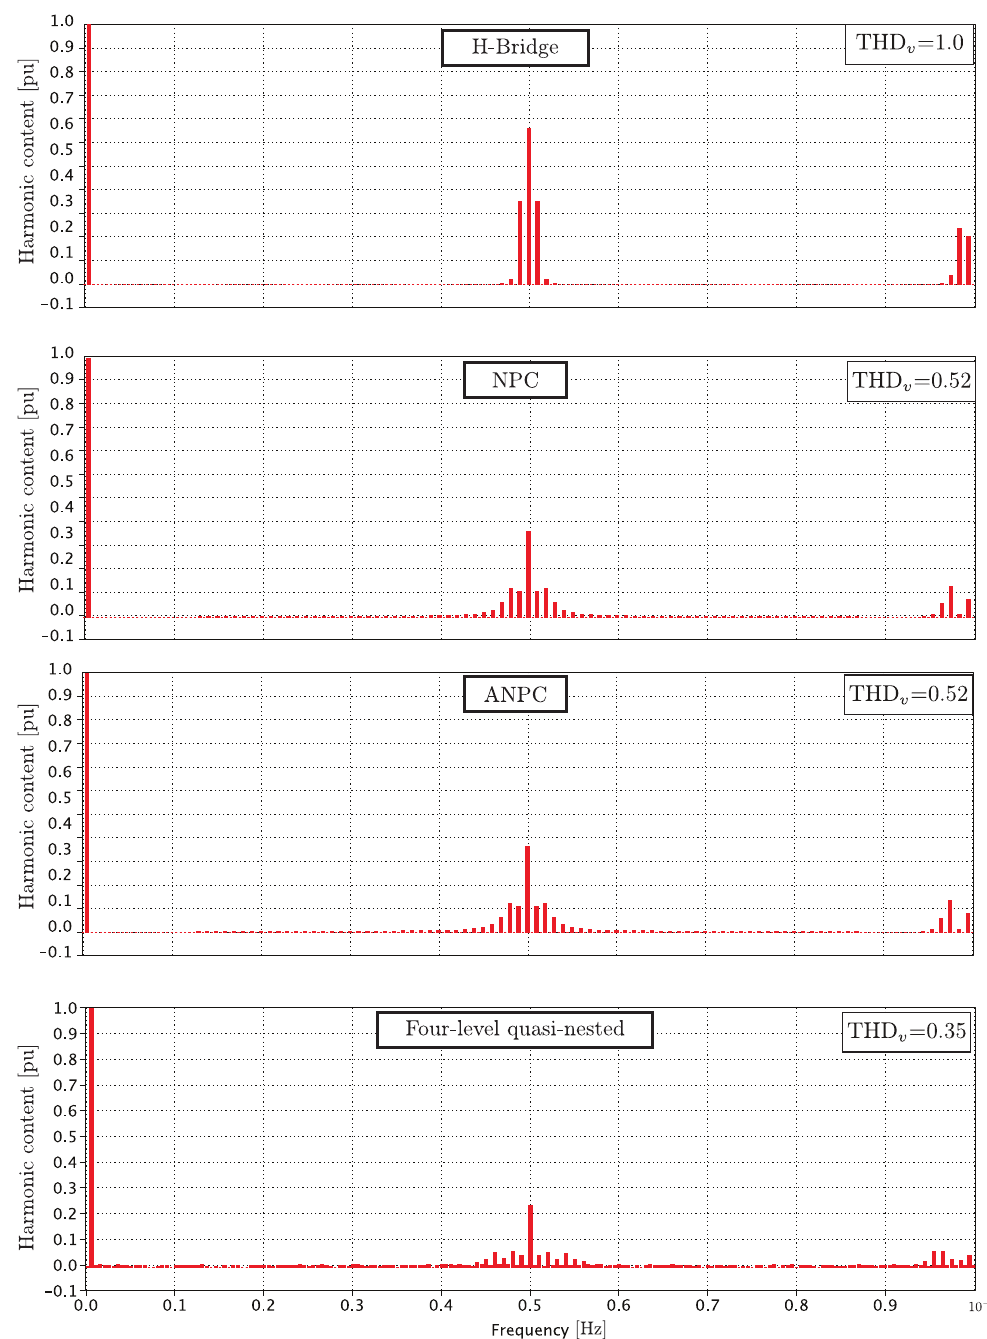
Figure 15. Simulation result: voltage harmonic spectrum of the 4L-QN inverter and conventional counterparts ( m =